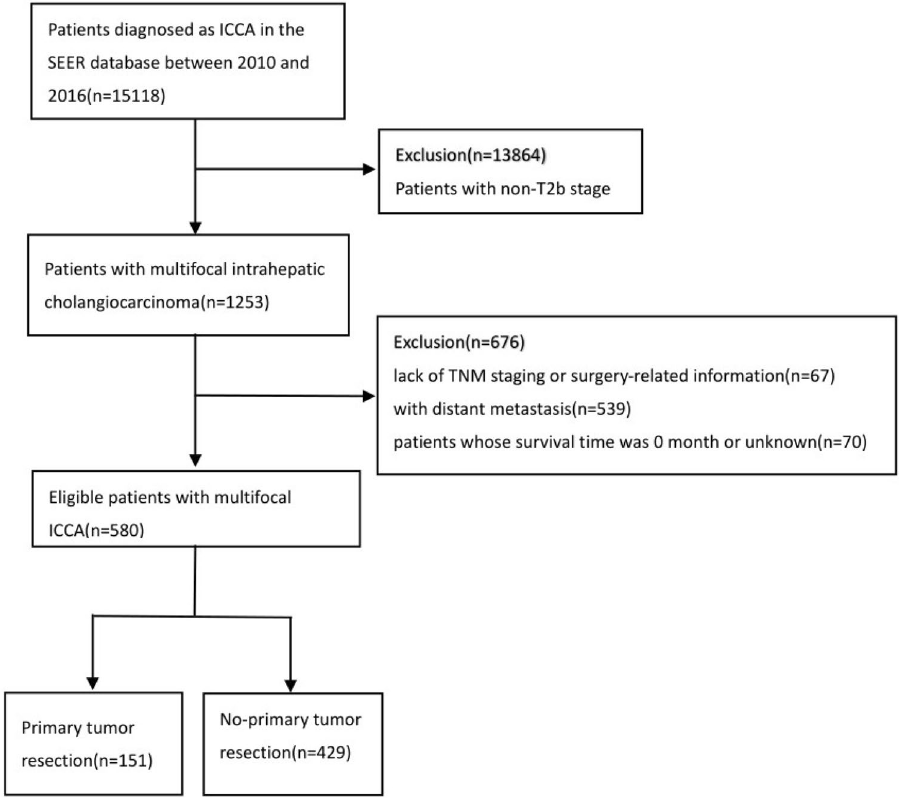
Figure 1. Flow diagram of eligible patients diagnosed with multifocal intrahepatic